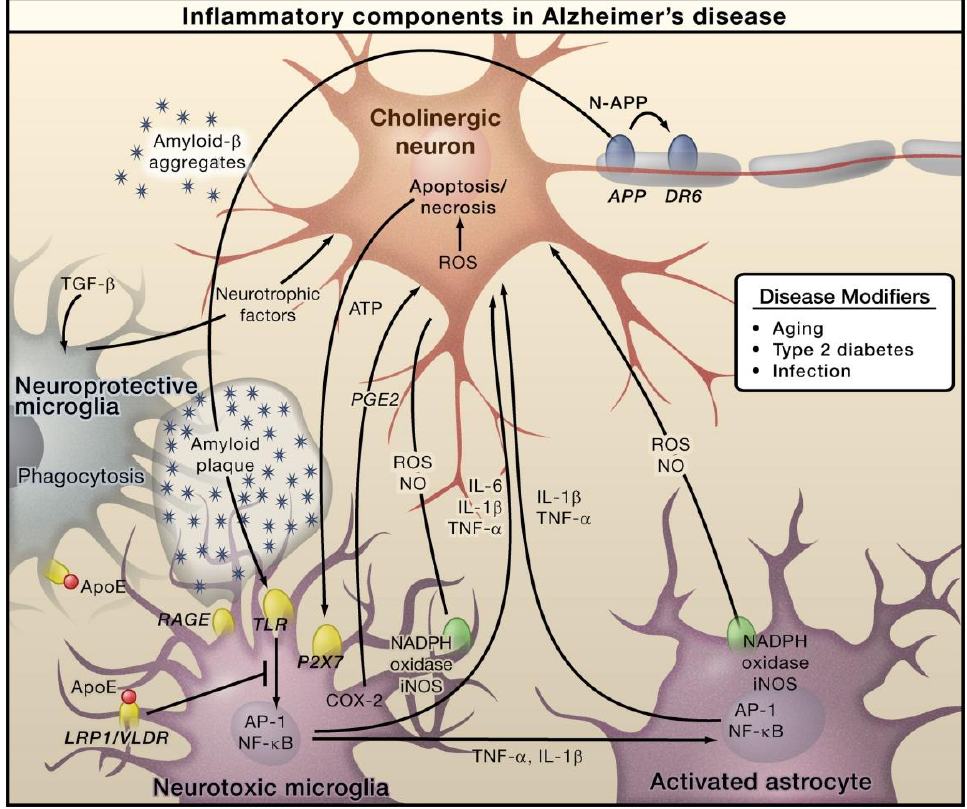
Figure 1. The role of inflammation mediators in the pathogenesis of Alzheimer’s disease. Reproduced with permission from Elsevier [47].